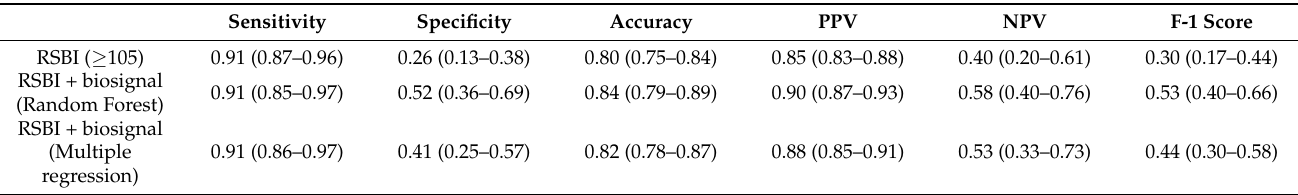
Table 3. Performance indices (accuracy, sensitivity, specificity, positive predictive value, negative predictive value, and F-1